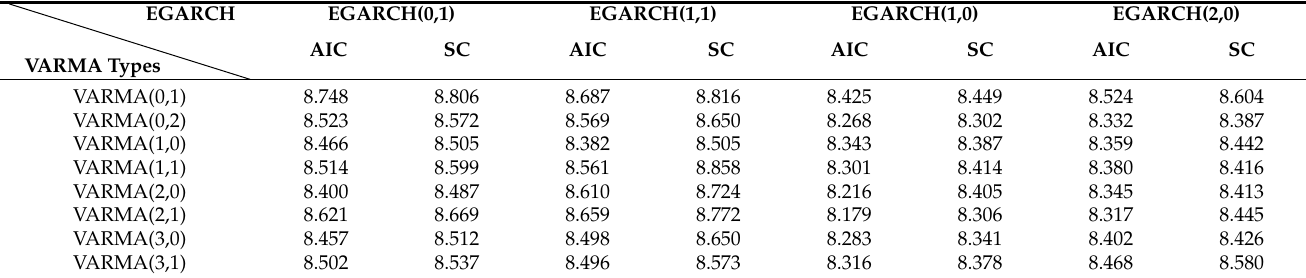
Table 4. Combinations of VARMA(p,q)-EGARCH(p,q) for mobile pollution factor.